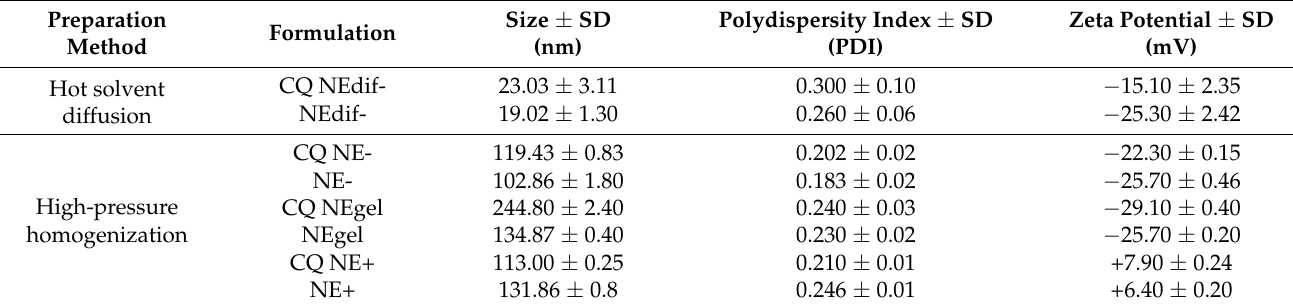
Table 2. Size, PDI, and zeta potential of the NEs.